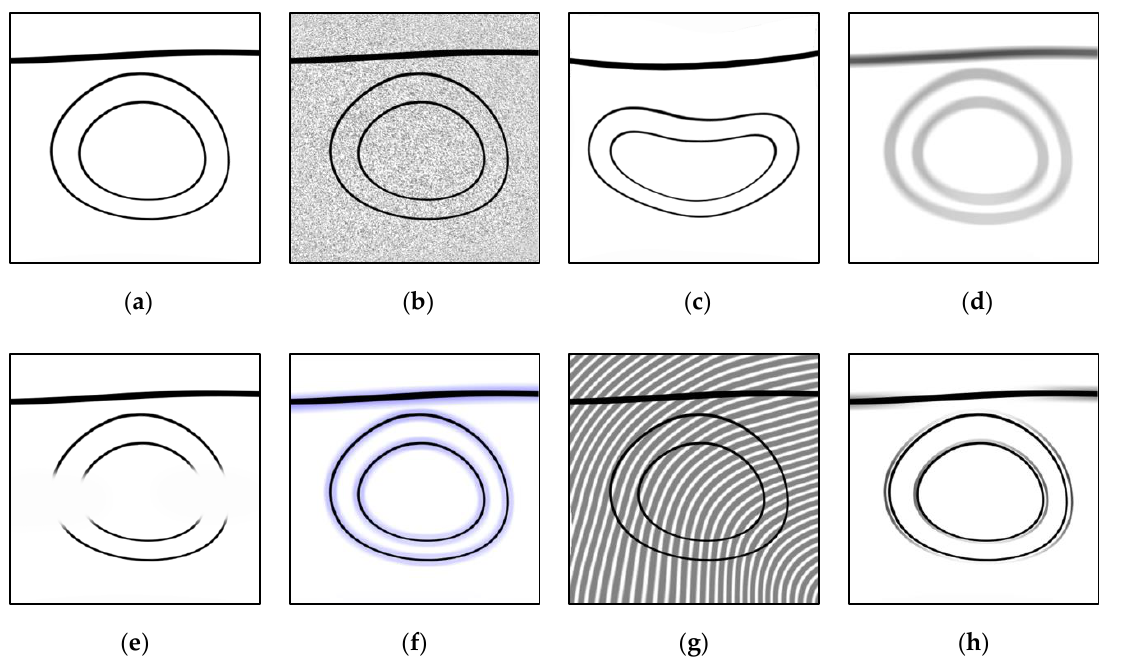
Figure 3. Image domain manifestations of limitations in hardware and algorithms. The upper thick line represents the skin boundary. The circular shapes represent optoacoustic absorbers in tissue. ( a ) Original, unaffected image. ( b ) Background noise due to limited illumination intensity. ( c ) Deformation resulting from acoustic mismatch. ( d ) Loss of high-frequency information (blurring) due to limited bandwidth acquisition. ( e ) Incomplete structure rendering due to limited-view acquisition. ( f ) Negative values (represented with blue) near dominant absorbers. ( g ) Aliasing artifacts. ( h ) Smearing due to inadequate modelling of transducer detector dimensions.